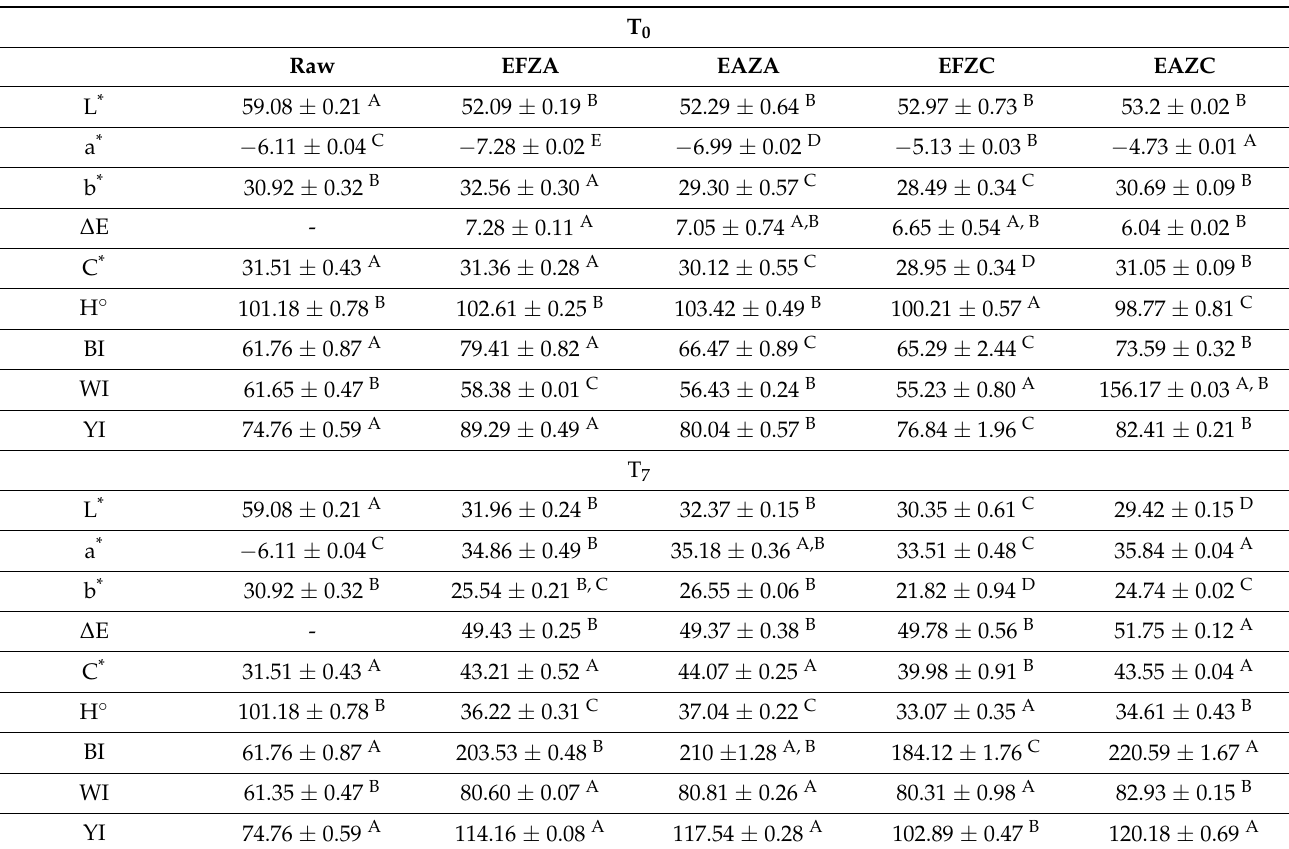
Table 3. Influence of heat treatments and storage on color parameters of zucchini purees enriched with anise or fennel aqueous